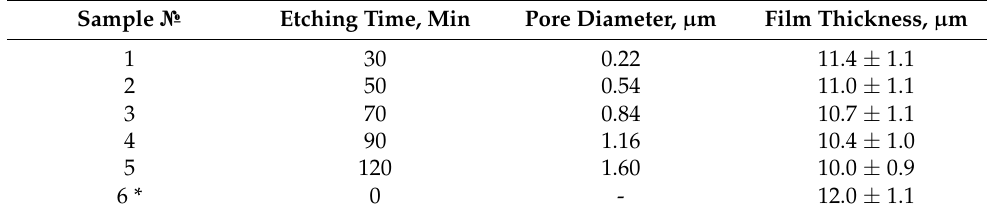
Table 1. Dependence of d on etching time for TM with n = 4 × 10 6 cm − 2